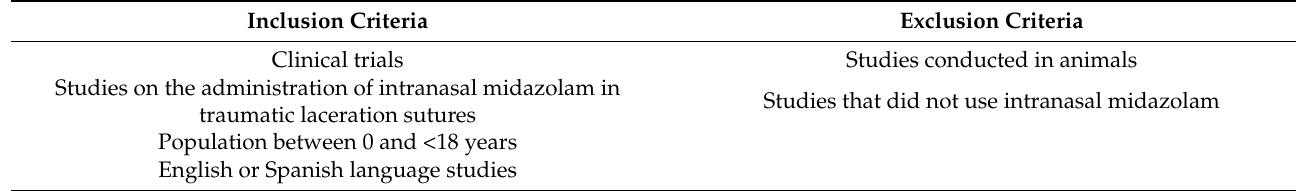
Table 2. Inclusion/exclusion